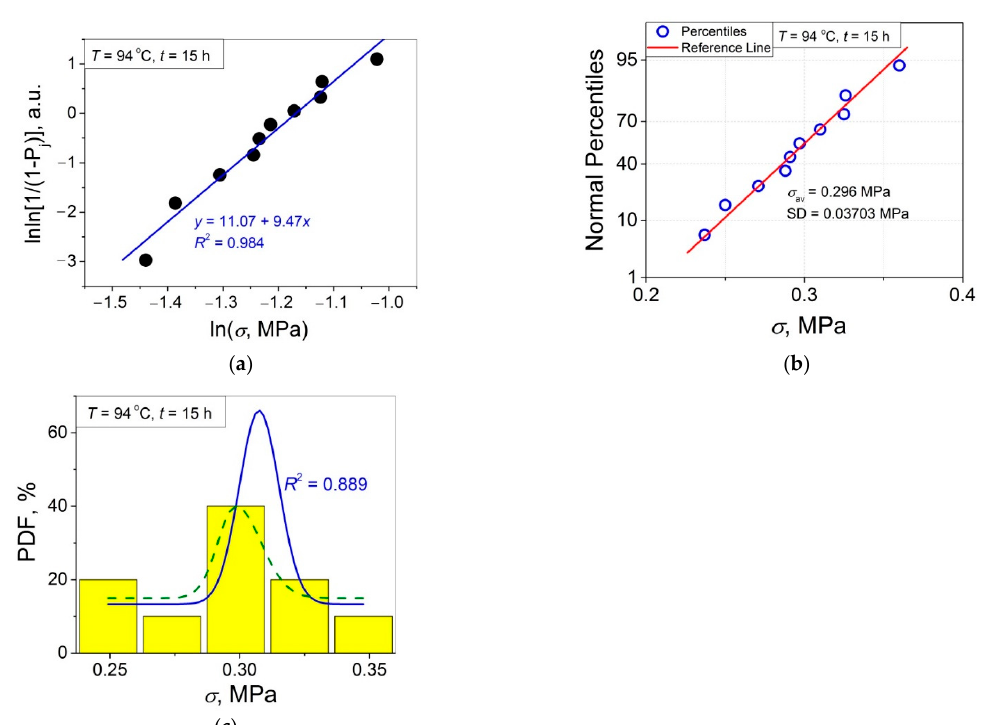
Figure 6. ( a ) Linear regression fit of the lap shear strength σ in Weibull’s coordinates; ( b ) normal probability plot; ( c ) probability density function (PDF) vs. σ fitted with a Gaussian (solid line) and bi-Gaussian functions for an amorphous PET–PET interface self-bonded at T = 94 °C for t = 15 h.